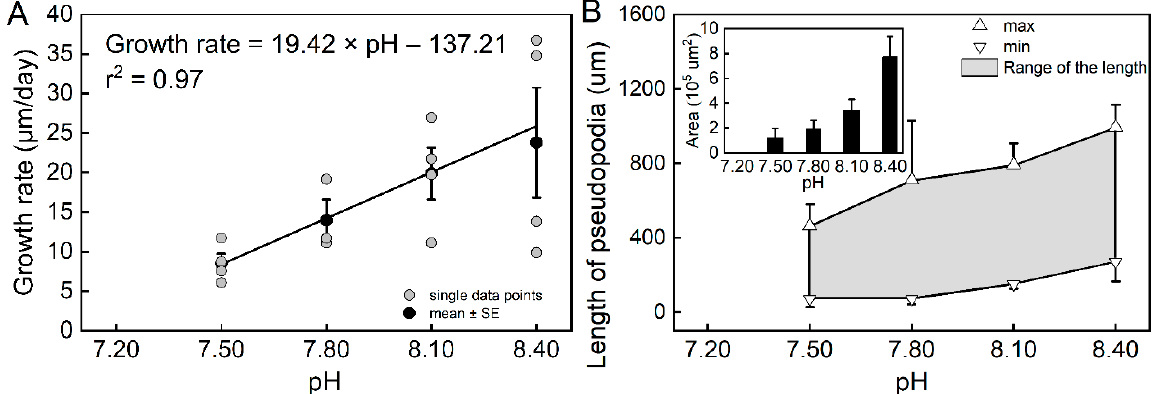
Figure 1. The relationship between the growth rate of Trilobatus sacculifer and seawater pH ( A ), and the variations in pseudopodia of T. sacculifer under different pH treatments ( B ). Note: All T. sacculifer individuals cultured at pH = 7.20 died within the first day, and the growth rate could not be calculated or analyzed for regression. Error bar = SE. The relatively high variability in the treatments of pH = 8.10 and pH = 8.40 could be a result of the relatively small sample sizes.